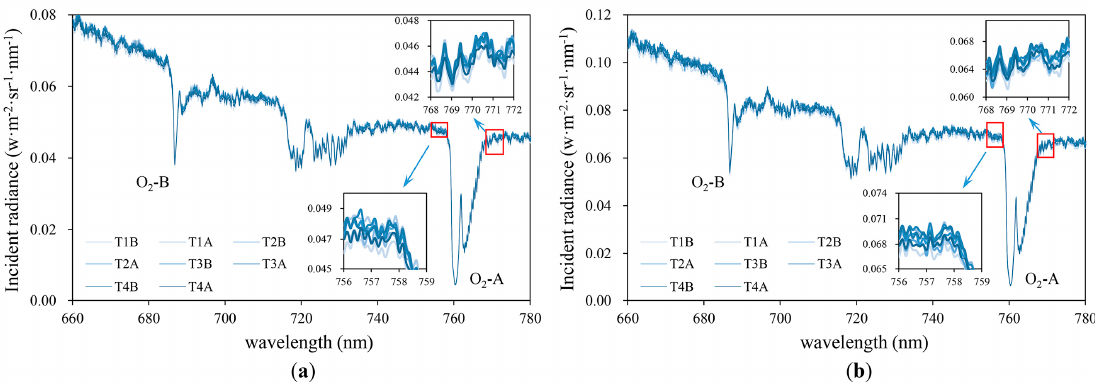
Figure 7. Incident radiance at: ( a ) 8:30 on 21 August; and ( b ) 8:30 on 22 August. T1 to T4 represent the four canopy targets, B and A denote measurements before and after canopy measurement, respectively.